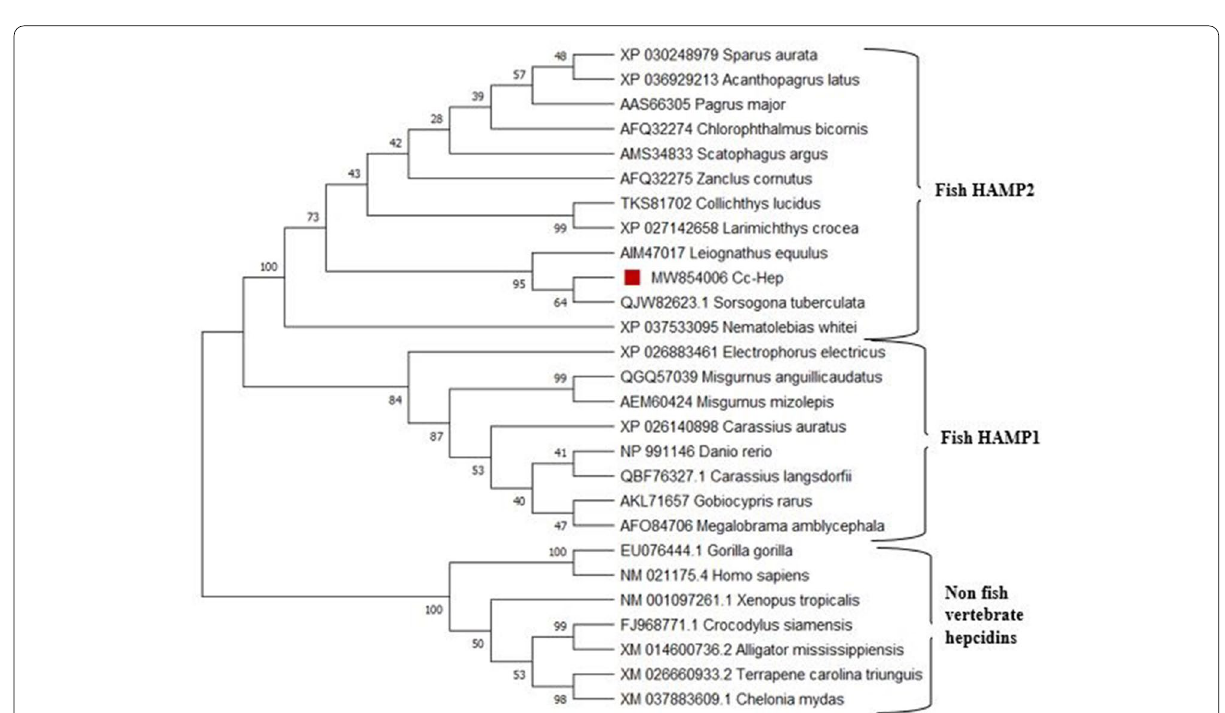
Fig. 5 Maximum likelihood tree obtained using MEGA 6 showing the phylogenetic relationship of Cc -Hep with other vertebrate